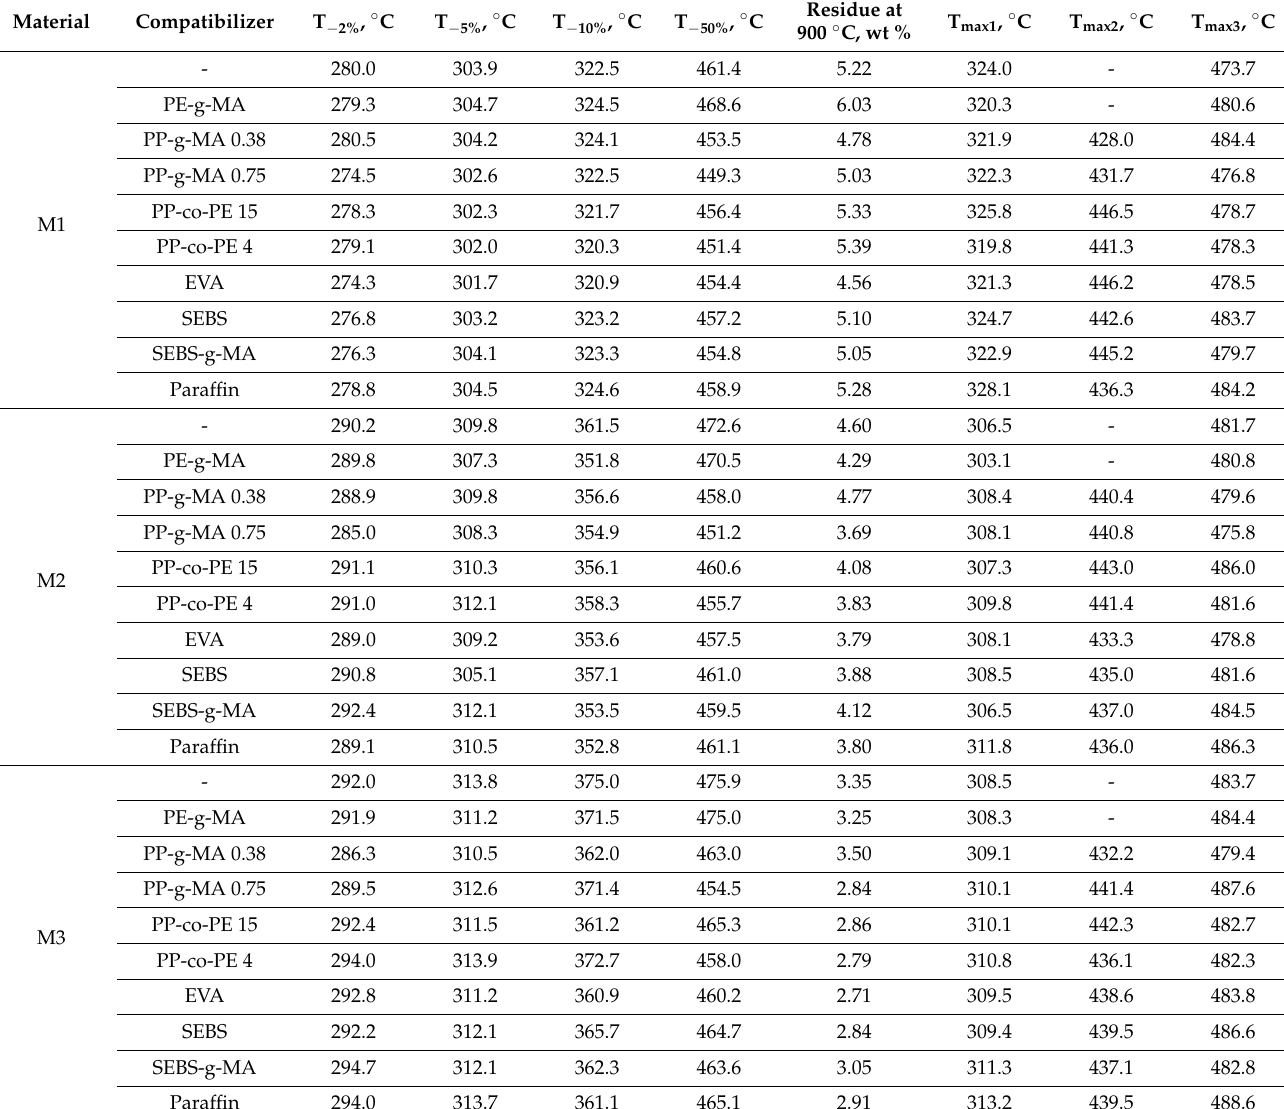
Table 5. Temperatures of 2, 5, 10 and 50% mass losses, values of residue at 900 ◦ C and temperature positions of peaks on differential thermogravimetric curves determined for compatibilized M1-M3